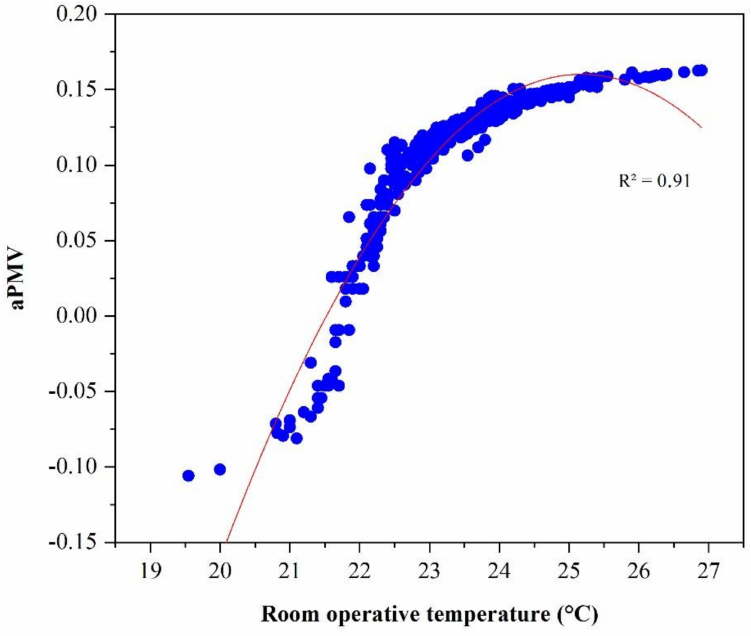
Figure 15. Adaptive predicted mean vote (aPMV) versus operative